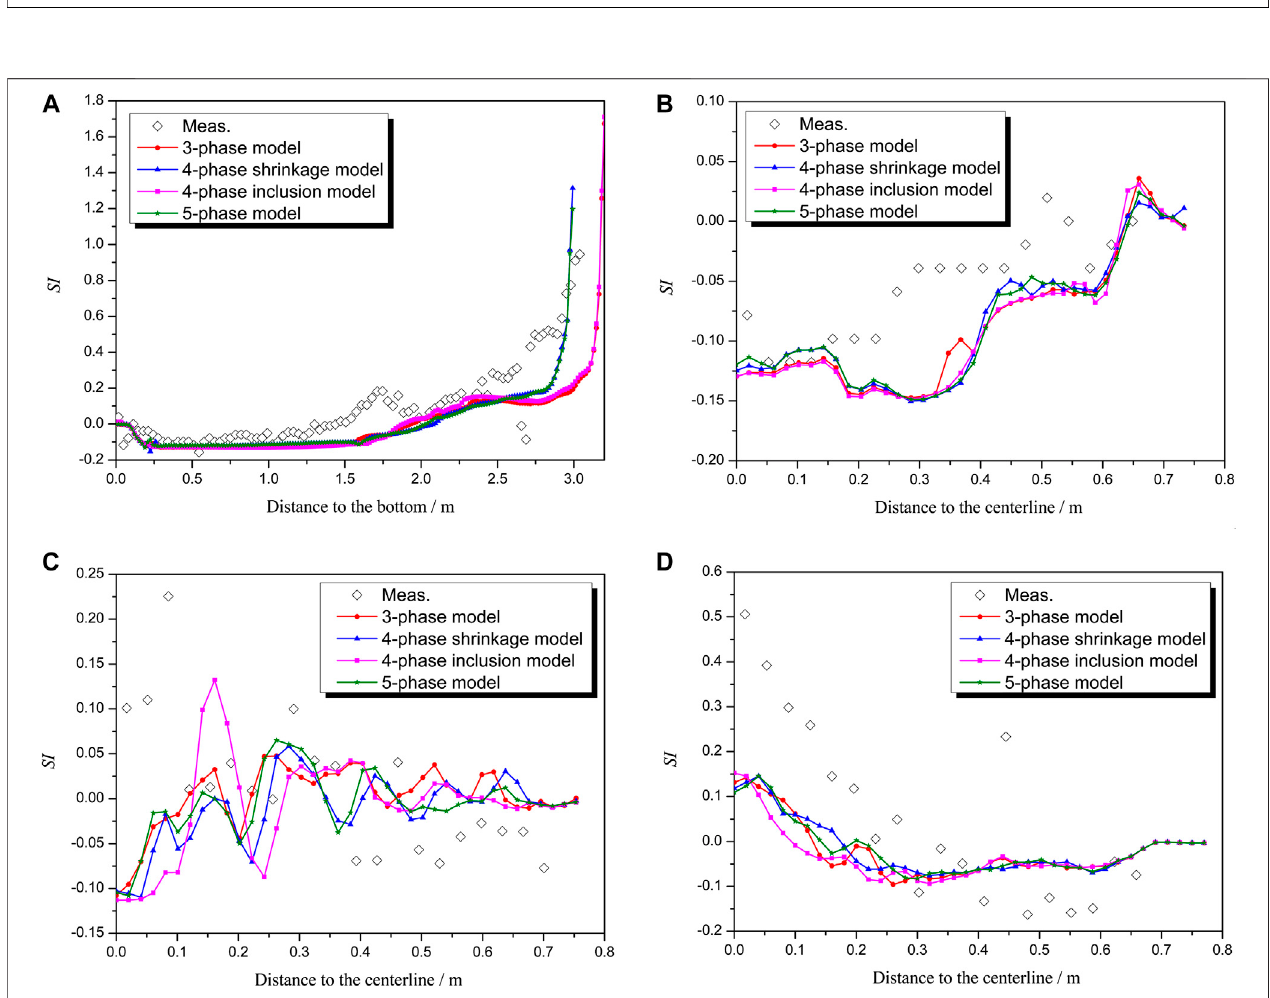
Frontiers in Materials |